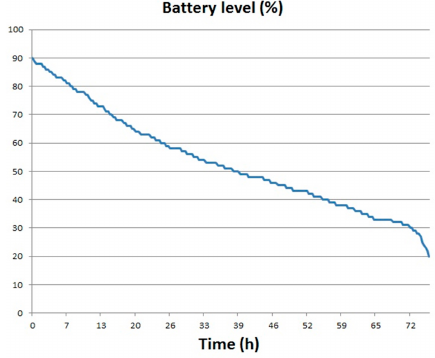
Figure 15. Battery level.